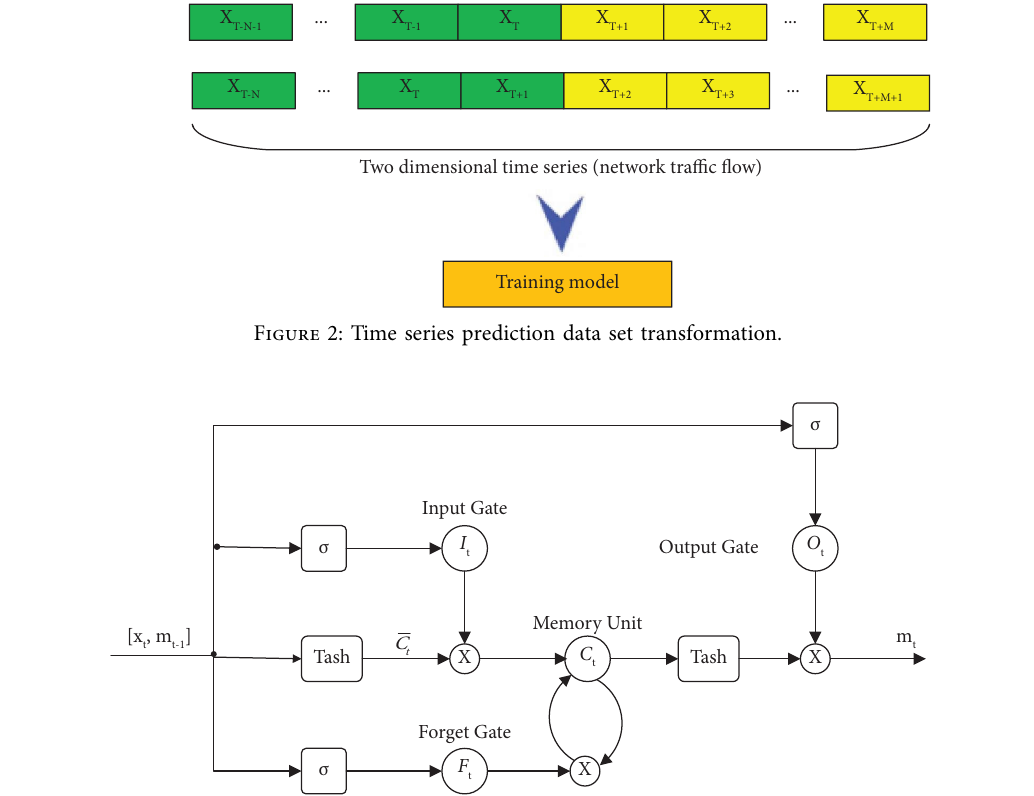
Figure 3: LSTM model hidden layer